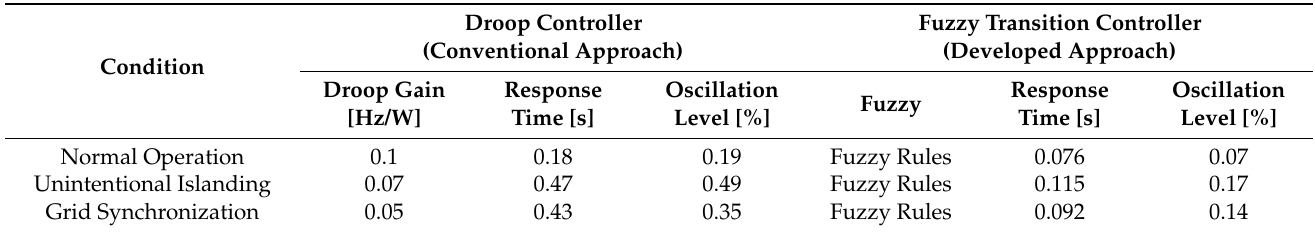
Table 4. Comparison between droop and fuzzy characteristics for all the simulation